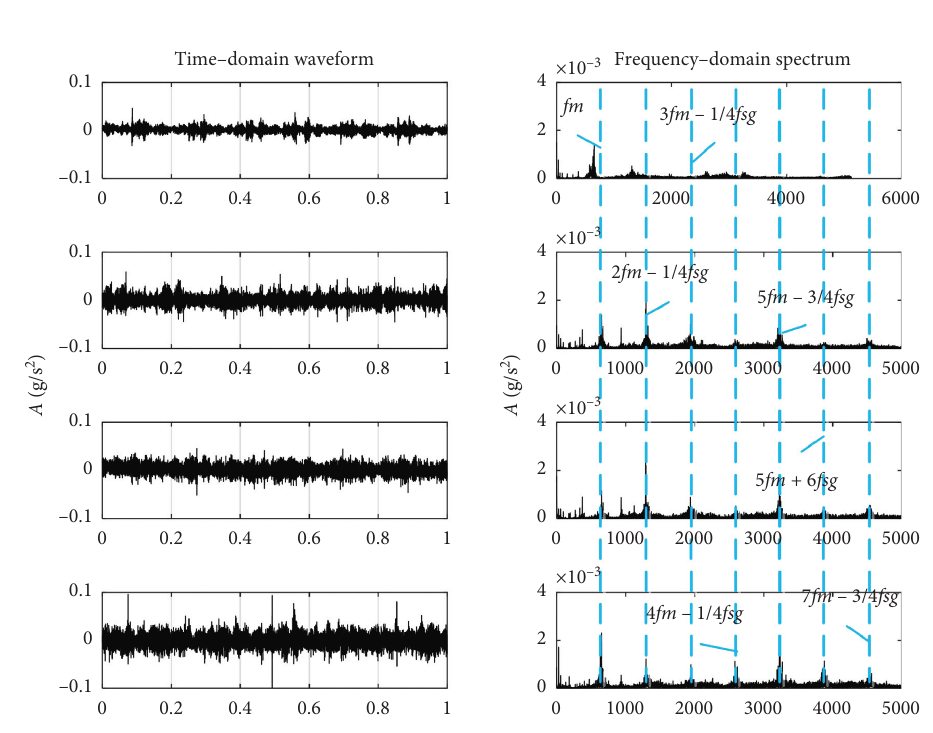
Figure 15: Time-domain waveform and frequency-domain spectrum for no crack and three crack